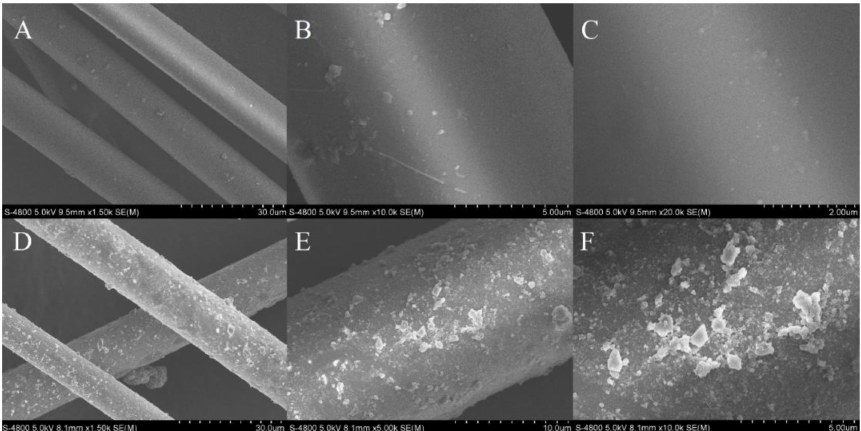
Figure 2. SEM diagrams of ( A – C ) bare basalt fibers and ( D – F ) basalt fibers functionalized with covalent organic porous